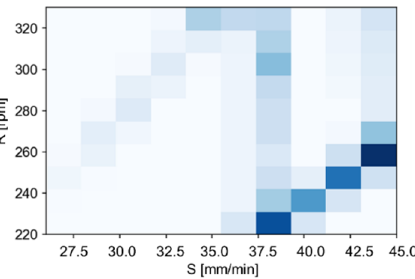
Figure 10. Histogram of the most common sets of parameters in the 5% of the results that were the best (the darker the colour, the higher the frequency of occurrences).